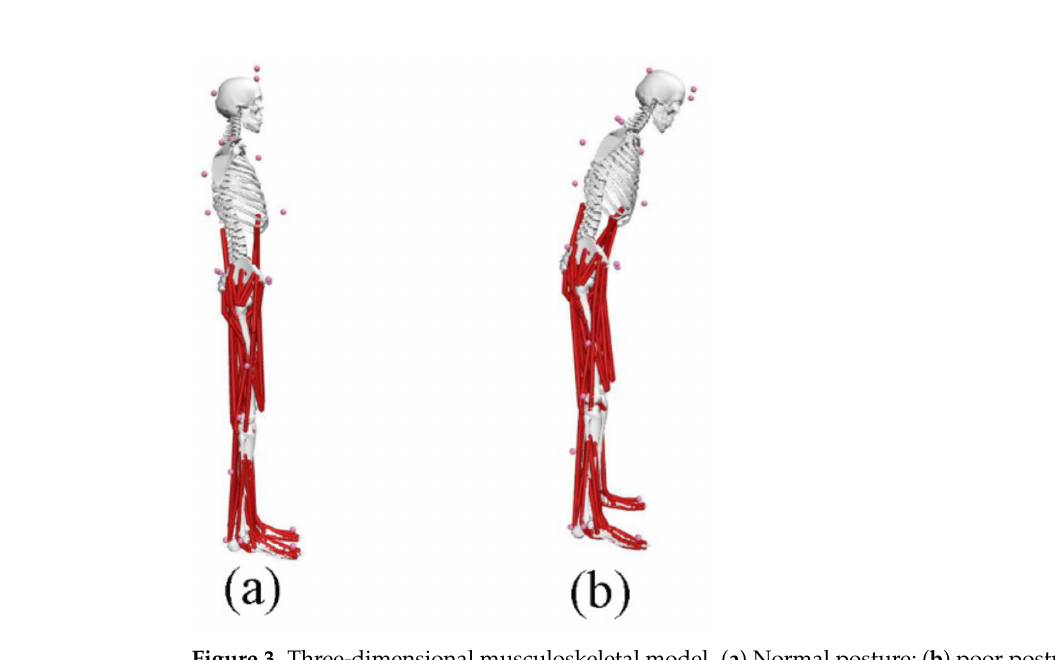
Figure 3. Three-dimensional musculoskeletal model. ( a ) Normal posture; ( b ) poor